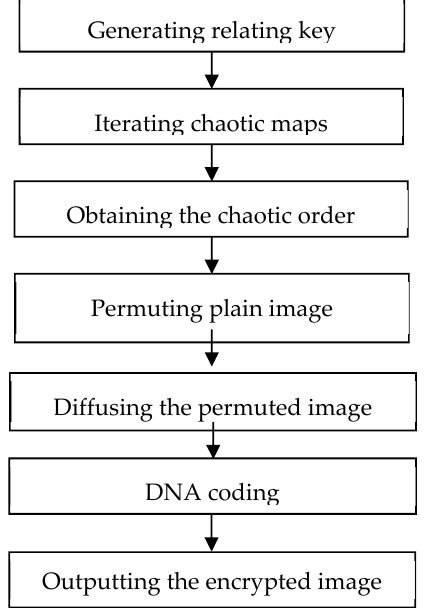
Figure 1. The flowchart of encrypting image.